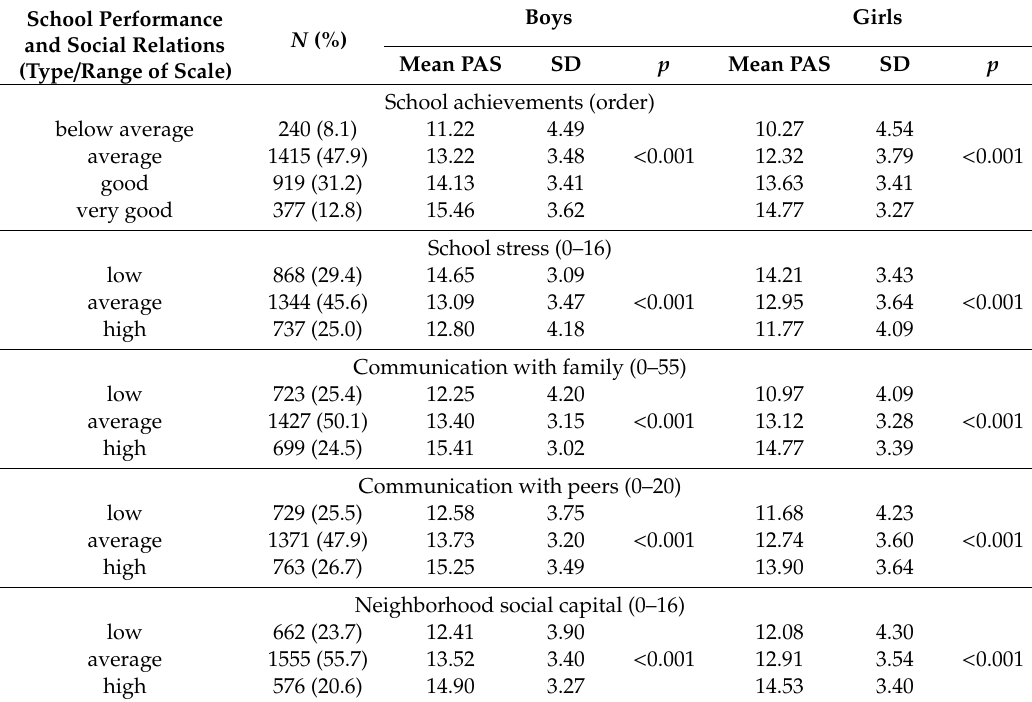
Table 2. Mean crude Positive Attitude Scale (PAS) scores according to school performance and social relations by